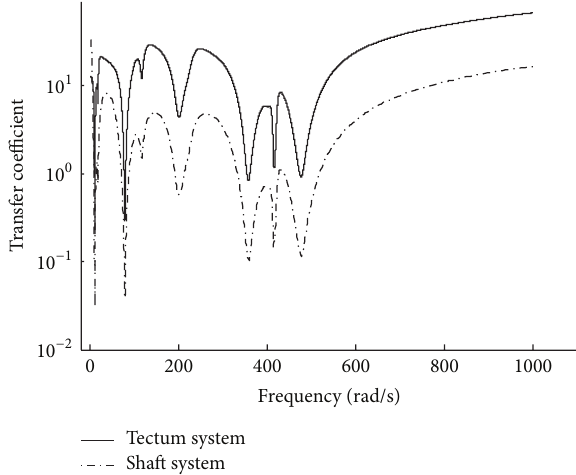
Figure 7: Transfer coefficient of the paths of the excitation fre- quency characteristic